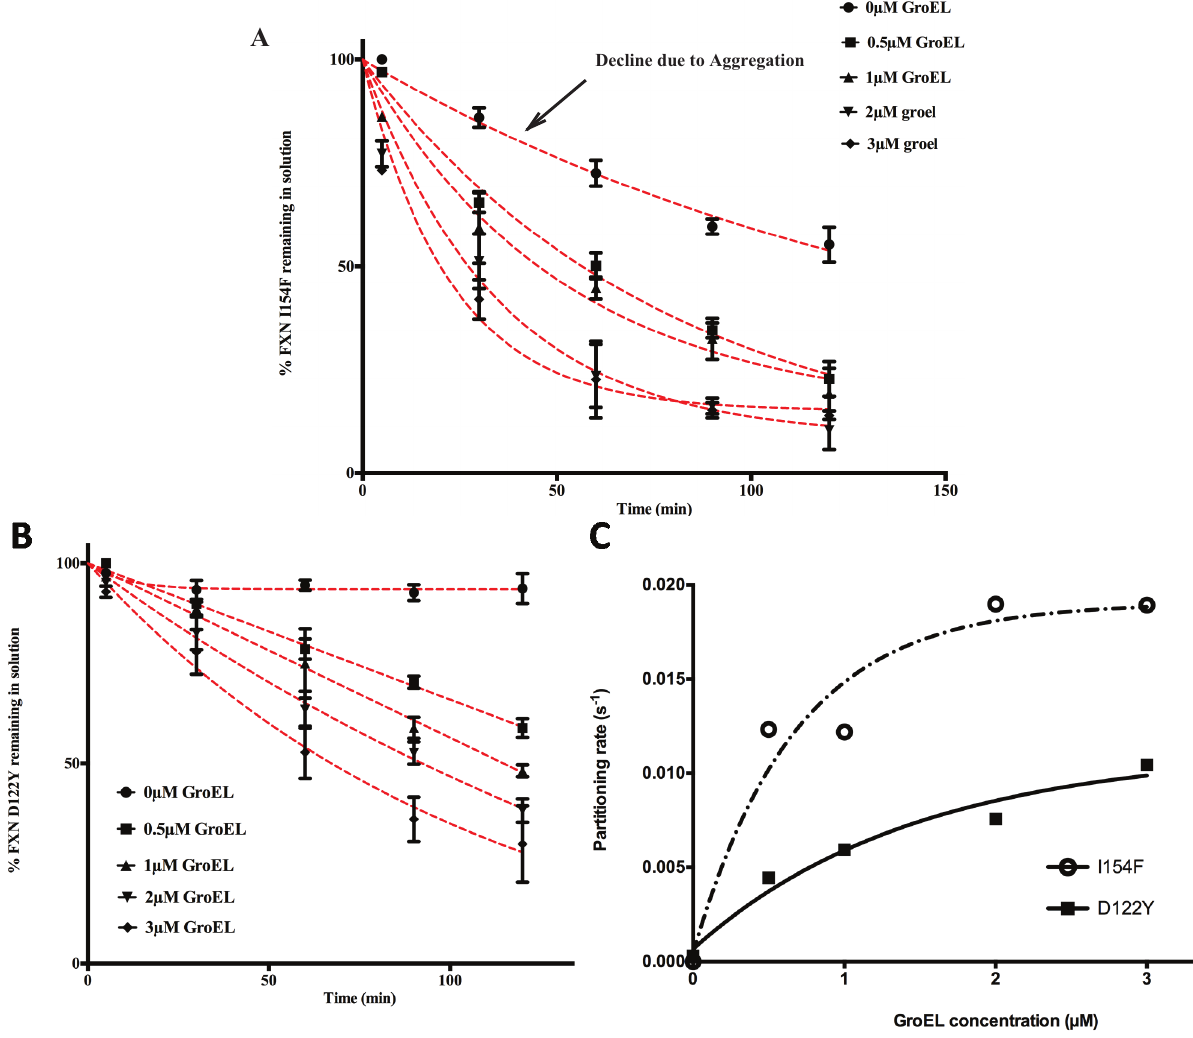
Figure 2. Effect of GroEL concentration on frataxin clinical variants partitioning profiles at 45 °C, 1 M urea. Frataxin Partitioning (2 μM) was analyzed using different estimated GroEL oligomer concentrations: control-no GroEL ((cid:8)), 0.5 μM ((cid:5)), 1 μM ( (cid:2) ), 2 μM ( (cid:3) ) and 3 μM ((cid:9)); ( A ) FXN-p.Ile154Phe (FXN I154F) and ( B ) FXN-p.Asp122Tyr (FXN